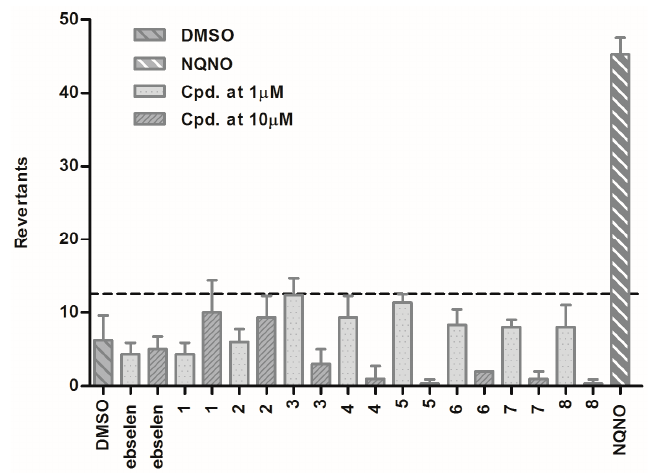
Figure 2. Results of the Ames liquid microtiter test and determination of the mutagenic potential; DMSO (1%)—negative control; ebselen-reference compound; NQNO (4-nitroquinoline- N -oxide)— mutagenic agent at concentration 0.5 µM; 1 – 8 —selenocompounds at concentrations 1 µM and 10 µM, respectively; —baseline defining the mutagenicity threshold (over the line). Table 5. Mutagenic index (MI) values for ebselen and tested compounds ( 1 – 8 ). Cpd. MI (1 µM)